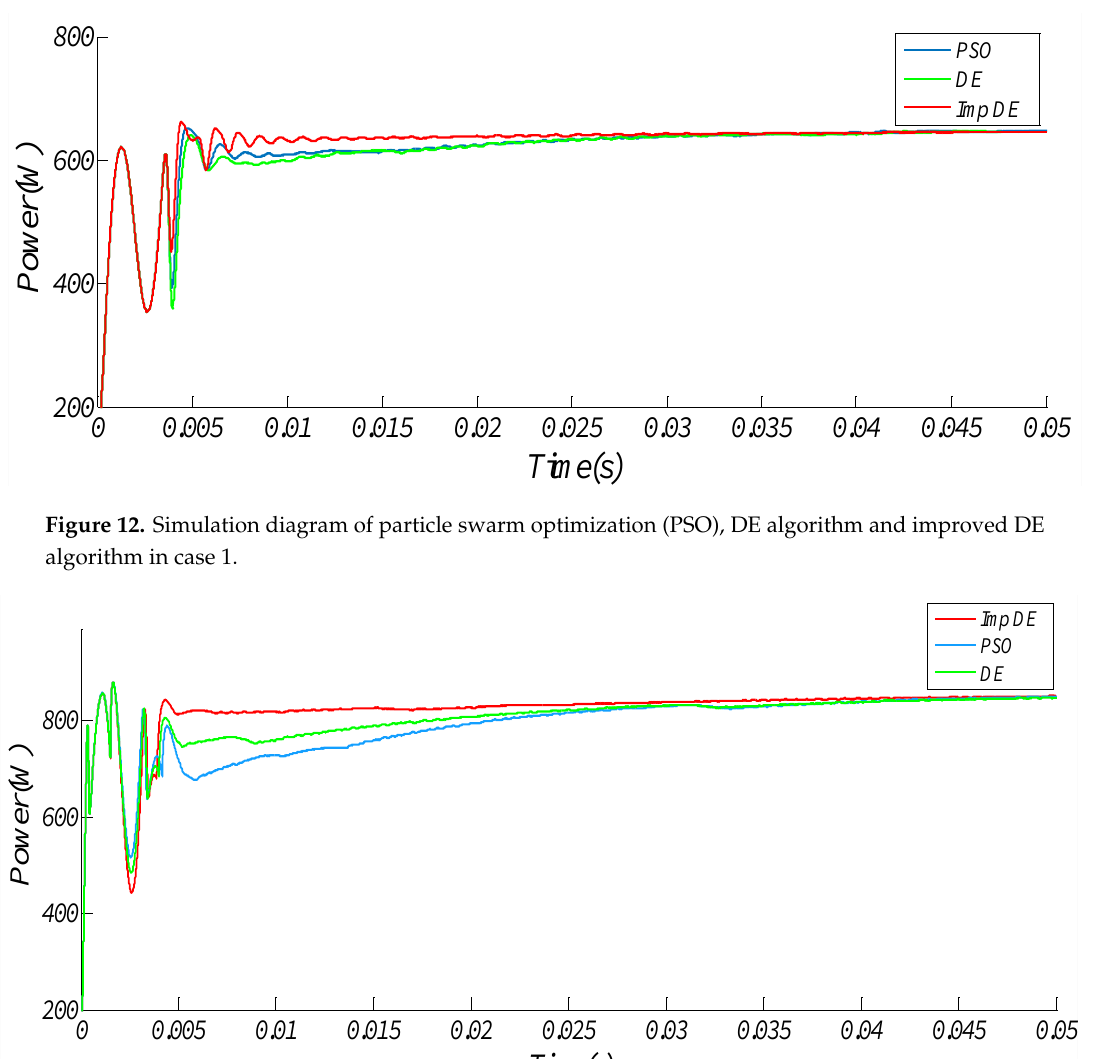
Figure 12. Simulation diagram of particle swarm optimization (PSO), DE algorithm and improved DE algorithm in case 1. Figure 13. Simulation diagram of PSO, DE algorithm and improved DE algorithm in case 2.